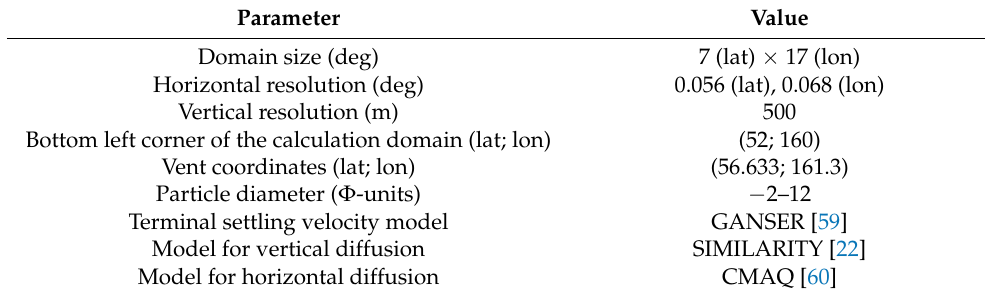
Table 3. FALL3D model parameters.